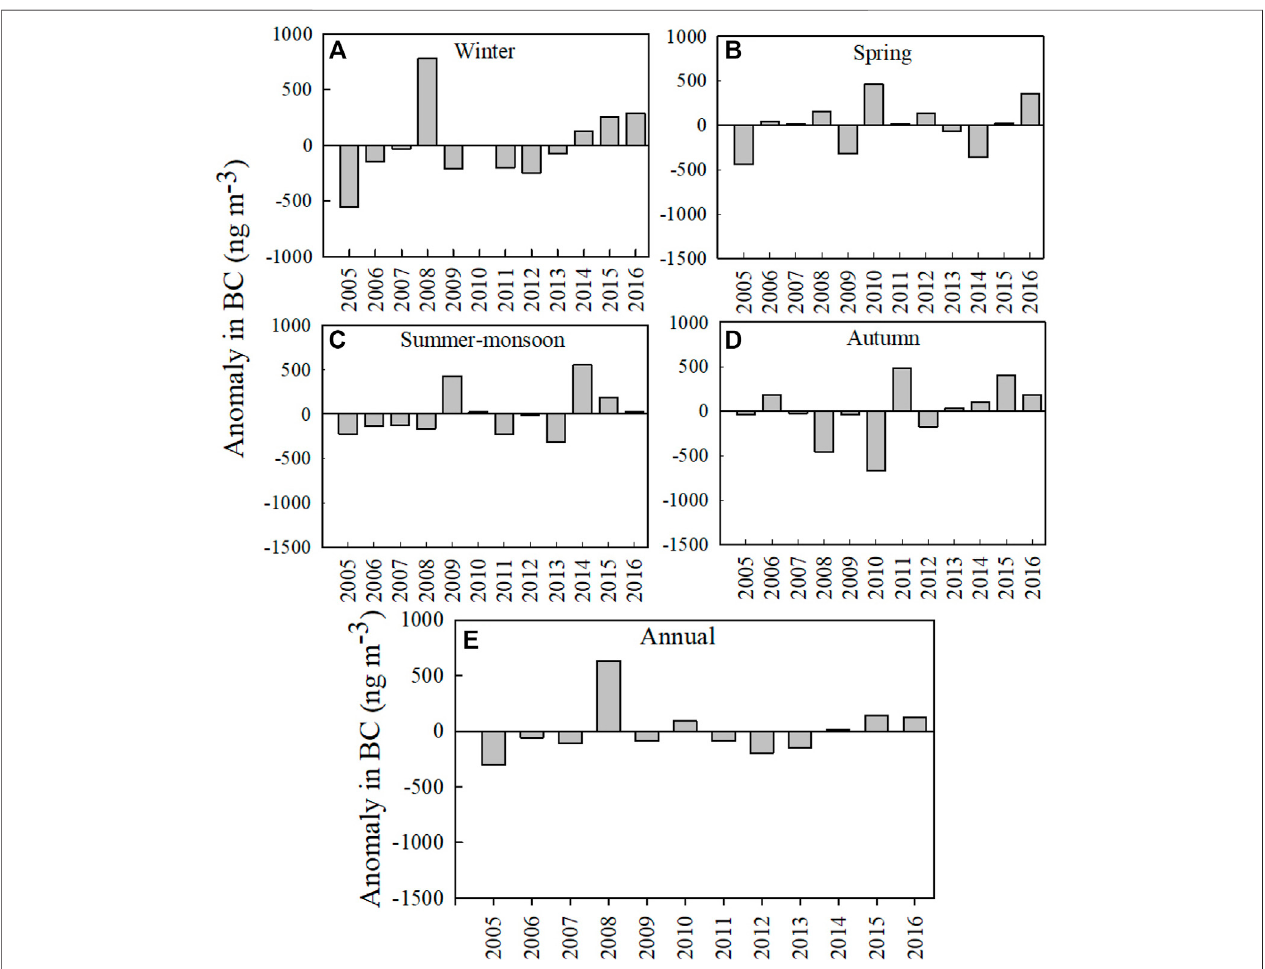
FIGURE 5 | Seasonal anomaly in BC calculated from the (A) seasonal mean BC for winter (DJF), (B) spring (MAM), (C) summer – monsoon (JJA), and (D) autumn (SON). (E) Seasonal anomaly in BC is also calculated from the annual mean BC for the years 2005 – 2016.